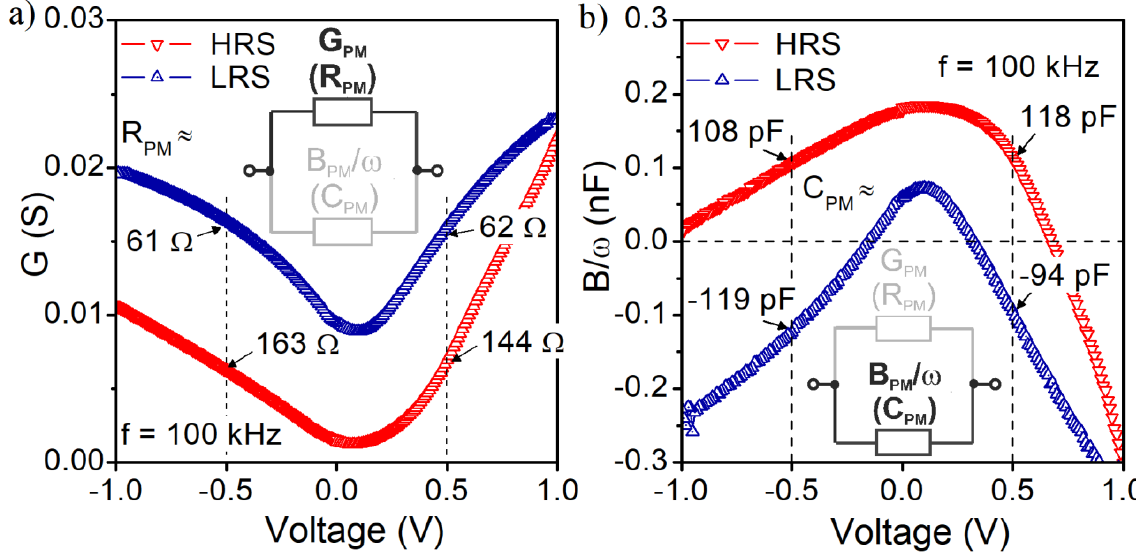
Figure 5. Measured current-voltage characteristics of Al/SiO2/n ++ Si RRAM structure S2 with the gate diameter of 74 μm and various compliance set currents.